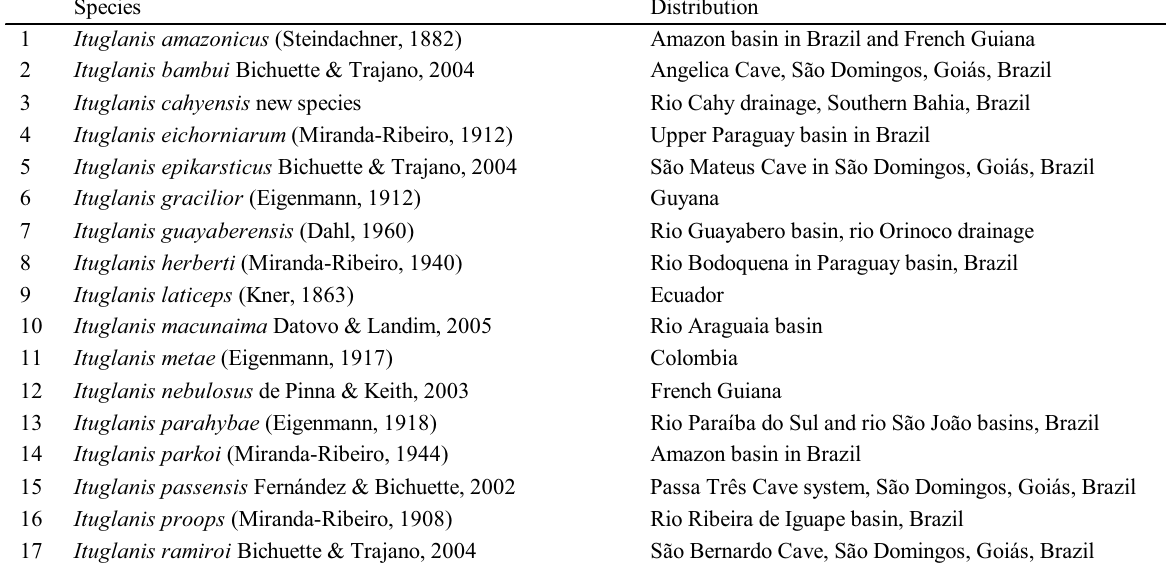
Table 1. Distribution of Ituglanis